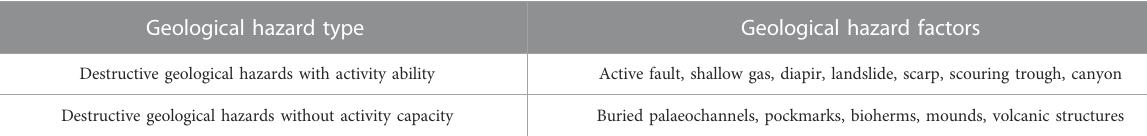
TABLE 1 Geological classi fi cation of disasters in the Xisha Sea